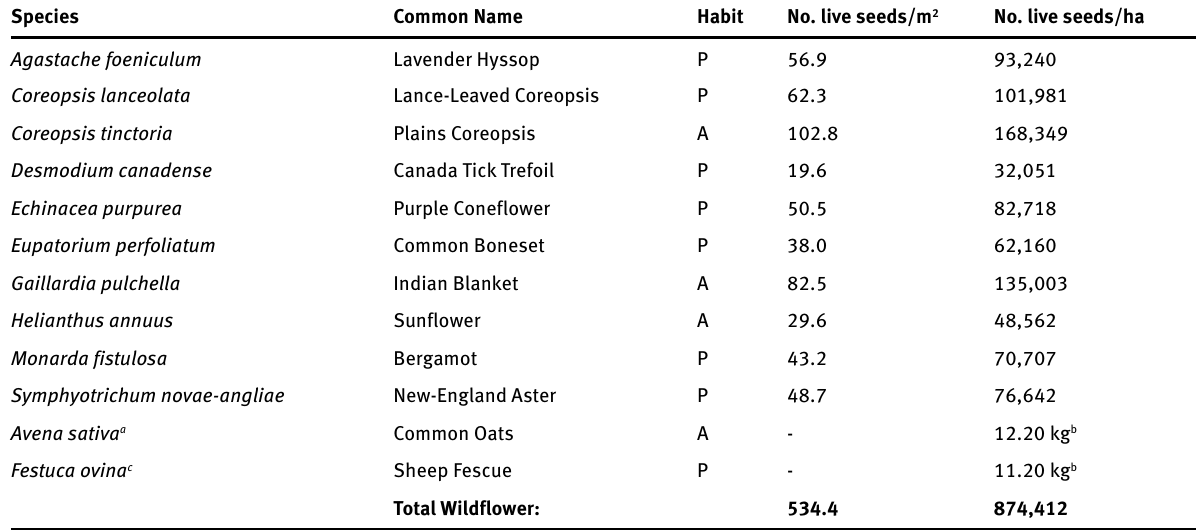
Table 1: List of sown species, habit, and seeding rates for wildflower PR treatment. Except A. sativa and F. ovina, values shown are supplied by Diane Wilson at Applewood Seed Company. Standard Errors for pure live seed values (no. live seeds per unit area) are not available